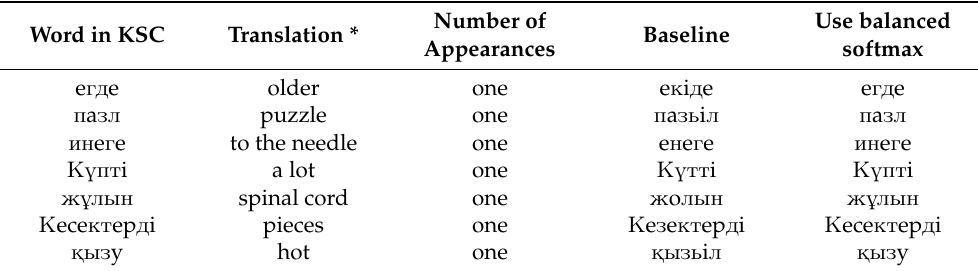
Table 5. Before and after comparison experiments of some low-frequency words using balanced softmax. Translation * using online translation.